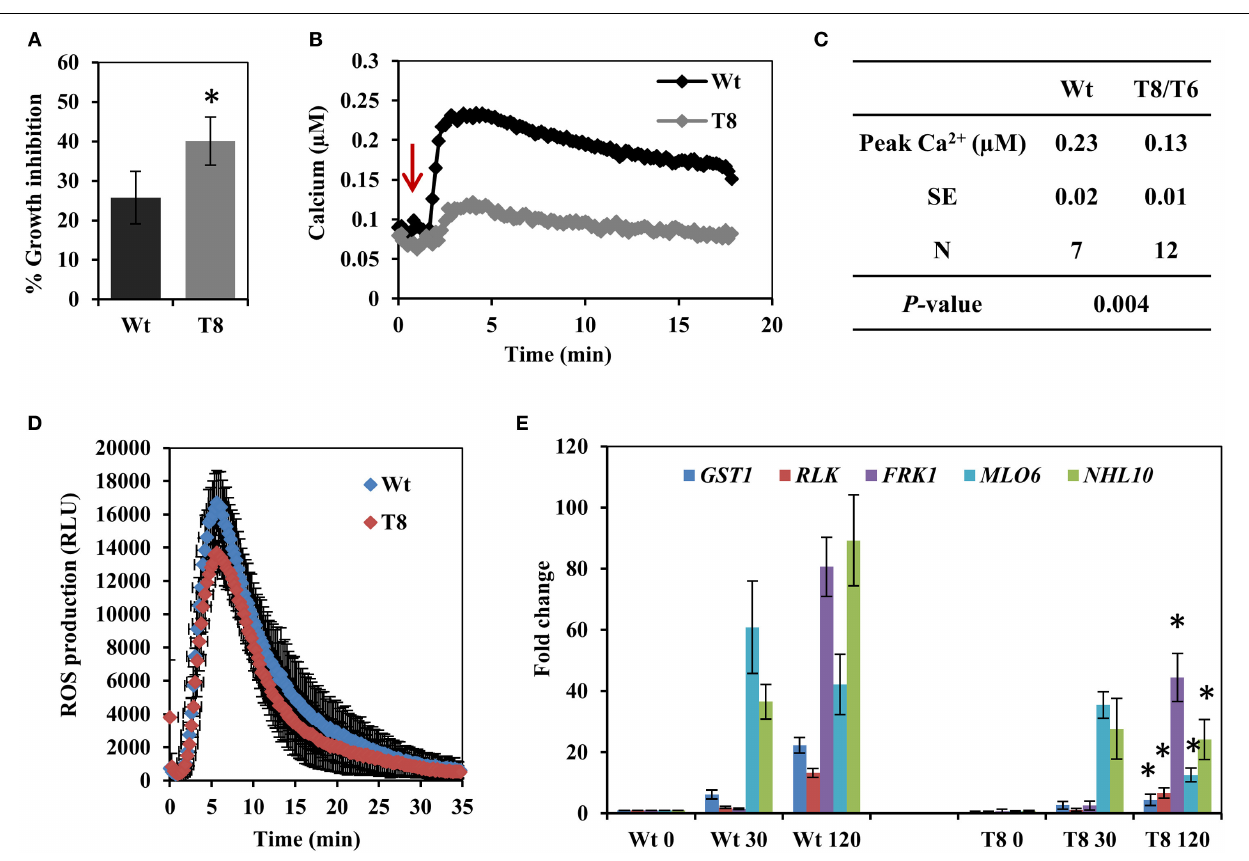
FIGURE 1 | The response of the InsP 5-ptase plants to flagellin. (A) One week old wild type (Wt) and InsP 5-ptase (T8) seedlings were incubated in media containing either 0 or 0.1 μ M flg22. Root length was measured after 5 days. Growth inhibition was calculated as the percentage of the non-treated control. Data is the average of four independent experiments ( n = 10 seedlings per experiment) ± SE. (B) Five-day old seedlings expressing aequorin were reconstituted with coelenterazine overnight and placed in the luminometer. Seedlings were treated with 10 μ M flg22 after 1min (indicated by red arrow). Ca 2 + concentrations were calculated after measuring the discharged Ca 2 + . A representative trace is